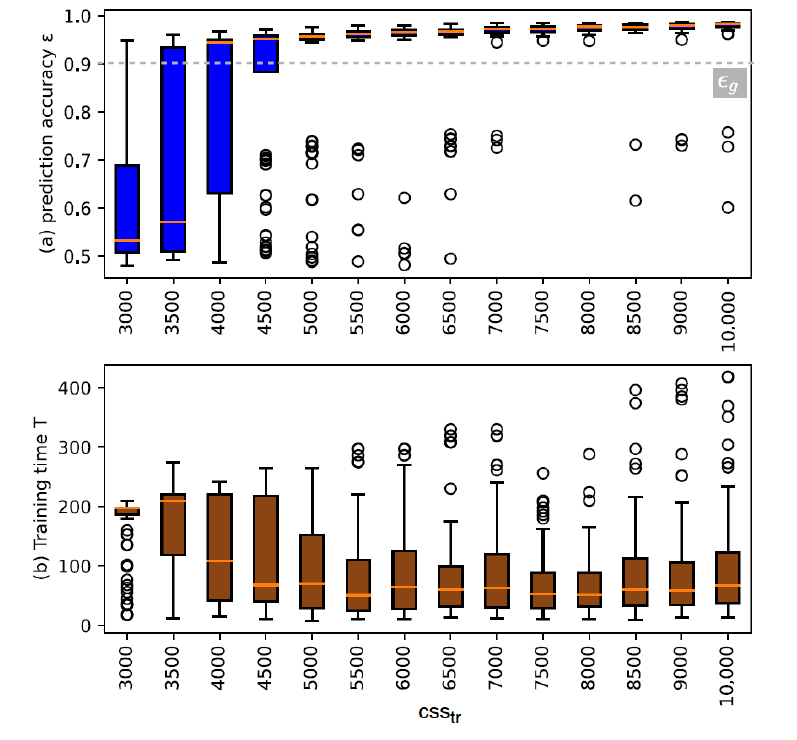
Figure 7. Illustrating the distribution of prediction accuracy (cid:101) and the distribution of total training time T over various css tr